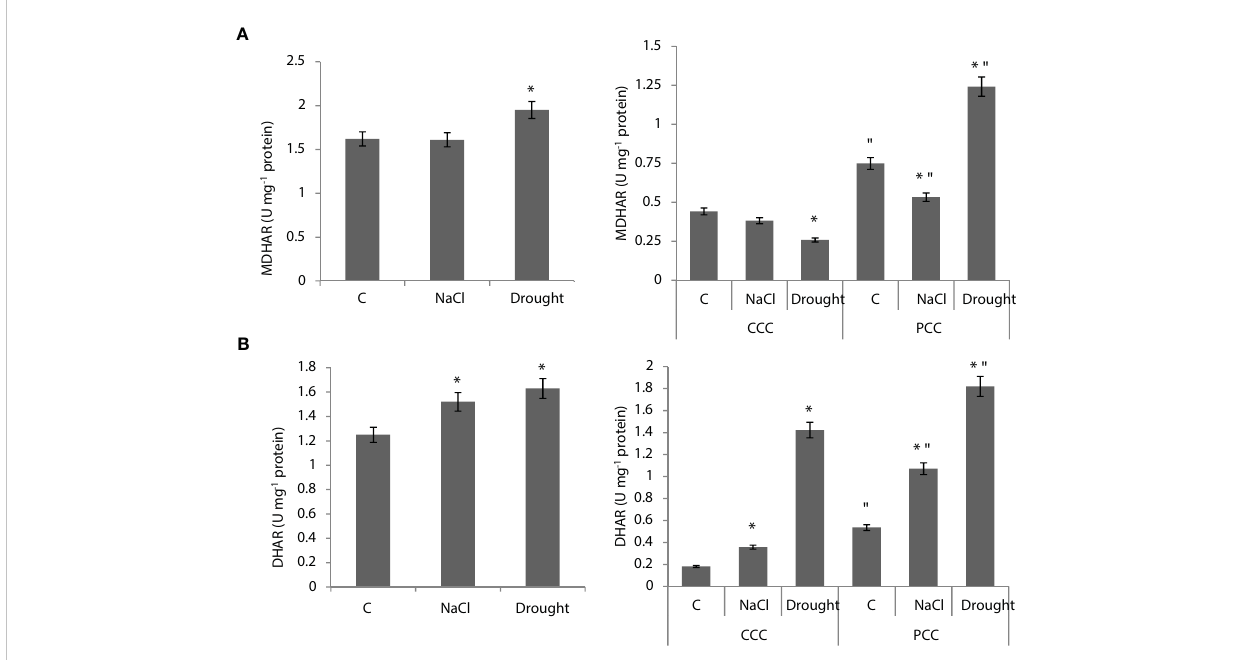
FIGURE 7 (A) MDHAR activity of whole leaves and CCC and PCC. (B) DHAR activity of whole leaves and CCC and PCC of Bienertia sinuspersici treated with 400 mM NaCl or water withholding for 10 d. “ * ” indicates signi fi cant difference (p < 0.05) as compared to controls. For CCC and PCC groups are compared to their own controls. When effects of treatments are compared between CCC and PCC, signi fi cant differences are shown with “